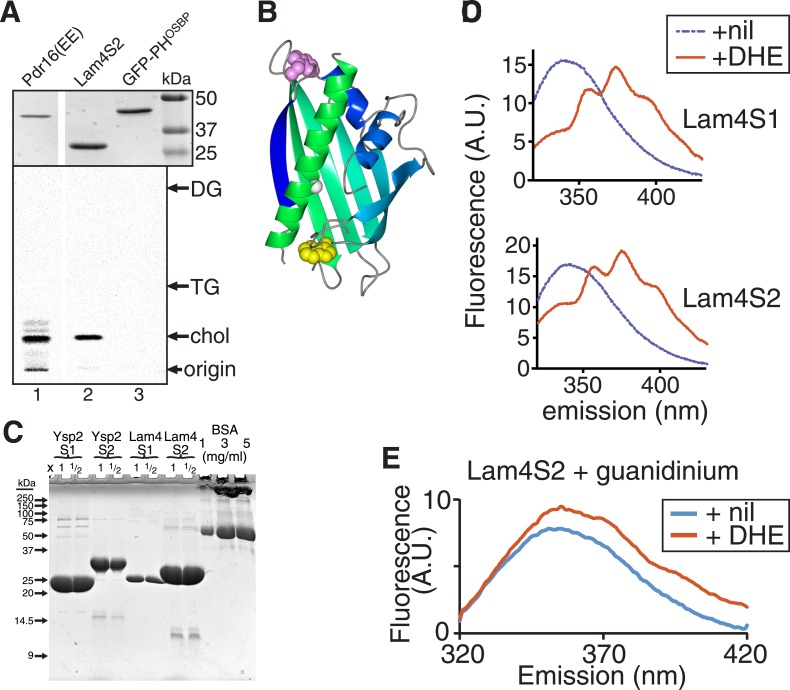
Lipid binding properties of StART-like domains.(A) Lam4S2 binding to cellular lipids (see Figure 2A). TOP: His6-tagged proteins (1) Pdr16(EE) (Holic et al., 2014), (2) Lam4S2, (3) GFP-PHOSBP were re-isolated after incubation with radiolabelled cells, separated by SDS-PAGE and stained by Coomassie (MW markers indicated). BOTTOM: Bound lipids that ran near the solvent front in the first TLC (Figure 2A) were scraped and re-separated to distinguish between cholesterol and other neutral lipids triacyl- and diacyl-glycerol (TG and DG). (B) Lam4S2 (966–1136) was modelled using SAM-T08 (Karplus, 2009), colored in a spectrum from N-terminus (blue) to C-terminus (green). Also shown: two conserved tryptophans either inside (yellow) or outside (pink) the pocket, a conserved glycine in the C-terminal helix (white = G1205 in Ysp2p, G1119 in Lam4p). (C) Stock solution of BSA and aliquots of the indicated purified StART-like domains (x1 and x1/2 volume compared to BSA) were run on a 15% SDS-PAGE gel that was stained by Coomassie. (D) FRET between Lam4S1 or Lam4S2 and DHE. Tryptophan fluorescence (excitation at 295 nm) with purified protein either on its own or incubated with DHE. (E) Tryptophan emission spectrum of Lam4S2 with and without DHE (as in panel C) but in the presence of 7 M guanidinium to denature the protein. This shows that DHE is only slightly fluorescent when stimulated at 295 nm.